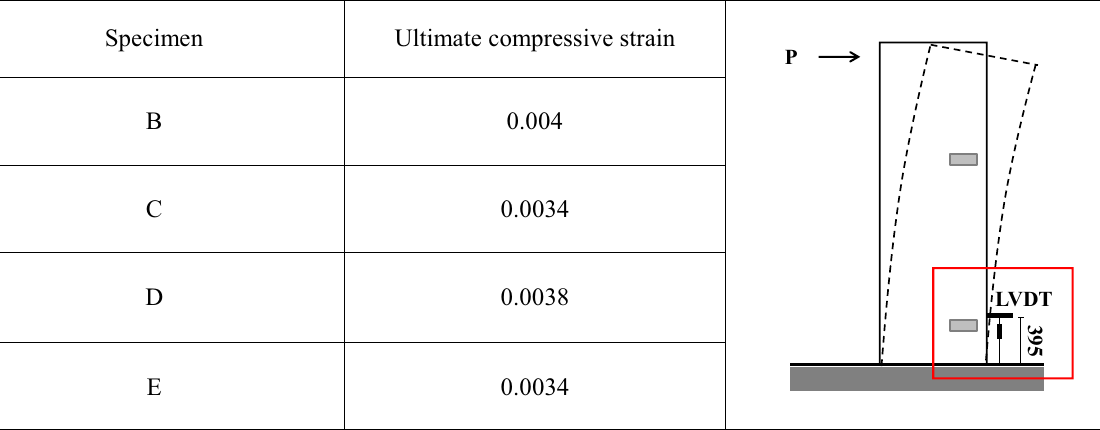
Table 5 Ultimate compressive strain at the bottom of the